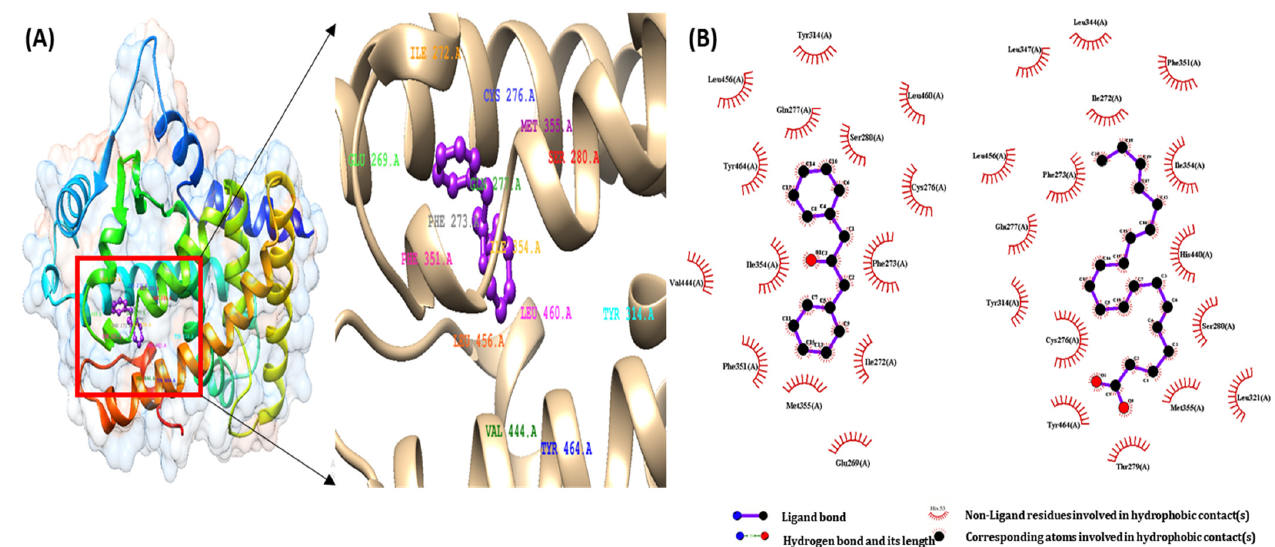
Figure 3 . ( A )The binding interactions of 1,3-Diphenyl-2-propanone ligand with PPAR α protein ( B ) pharmacophore analysis between PPAR α and active components of 1,3-Diphenyl-2-propanone and PPAR α - Eicosapentaenoic acid (control).